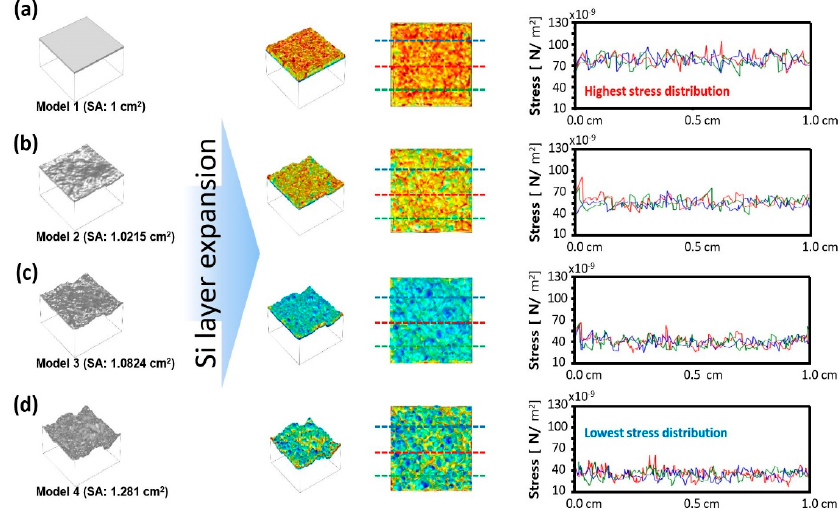
Figure 3. Simulation analysis of the mechanical stress applied to the Si layer when the Si layer undergoes volume-expansion: ( a ) row 1 (the bare Cu current-collector model): Surface area (SA) per unit area, 3D image of the volume-expansion during lithiation of the deposited Si layer, and stress distribution of the Si layer extracted from three locations along the X -axis; ( b ) row 2 (the Cu current-collector model irradiated with 10 W): SA per unit area, 3D image of the volume-expansion during lithiation of the deposited Si layer, and stress distribution of the Si layer extracted from three locations along the X -axis; ( c ) row 3 (the Cu current-collector model irradiated with 20 W): SA per unit area, 3D image of the volume-expansion during lithiation of the deposited Si layer, and stress distribution of the Si layer extracted from three locations along the X -axis; ( d ) row 4 (the Cu current-collector model irradiated with 30 W): SA per unit area, 3D image of the volume-expansion during lithiation of the deposited Si layer, and stress distribution of the Si layer extracted from three locations along the X